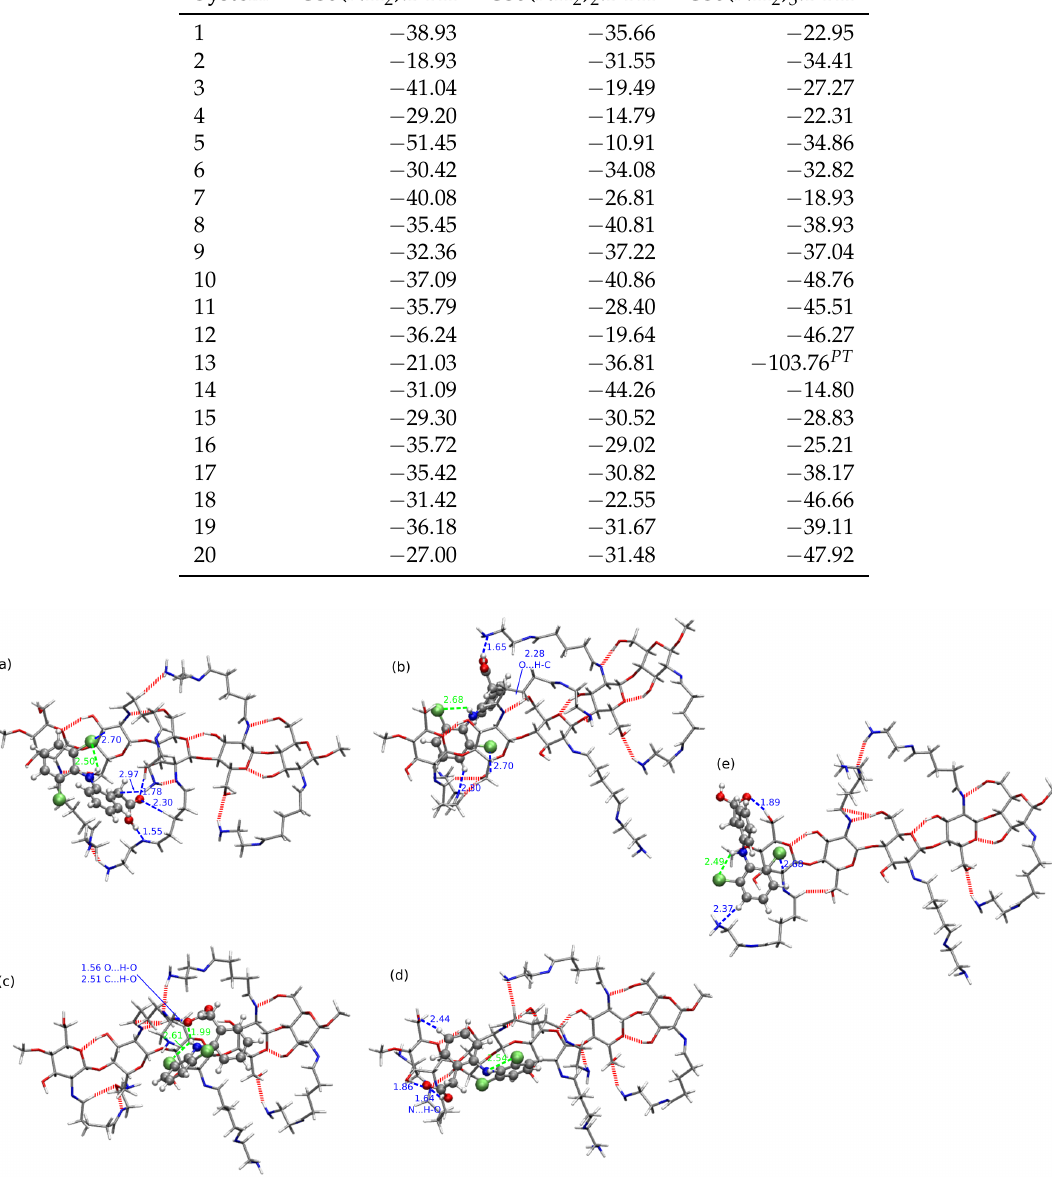
Figure 14. B97-D3/6-311++G(d,p) interaction in most attractive CS5(NH 2 ):DFH complexes: ( a ) CS5(NH 2 ):DFH 5 , ( b ) CS5(NH 2 ):DFH 3 , ( c ) CS5(NH 2 ):DFH 7 , ( d ) CS5(NH 2 ):DFH 1 and the weakest complex: ( e ) CS5(NH 2 ):DFH 2